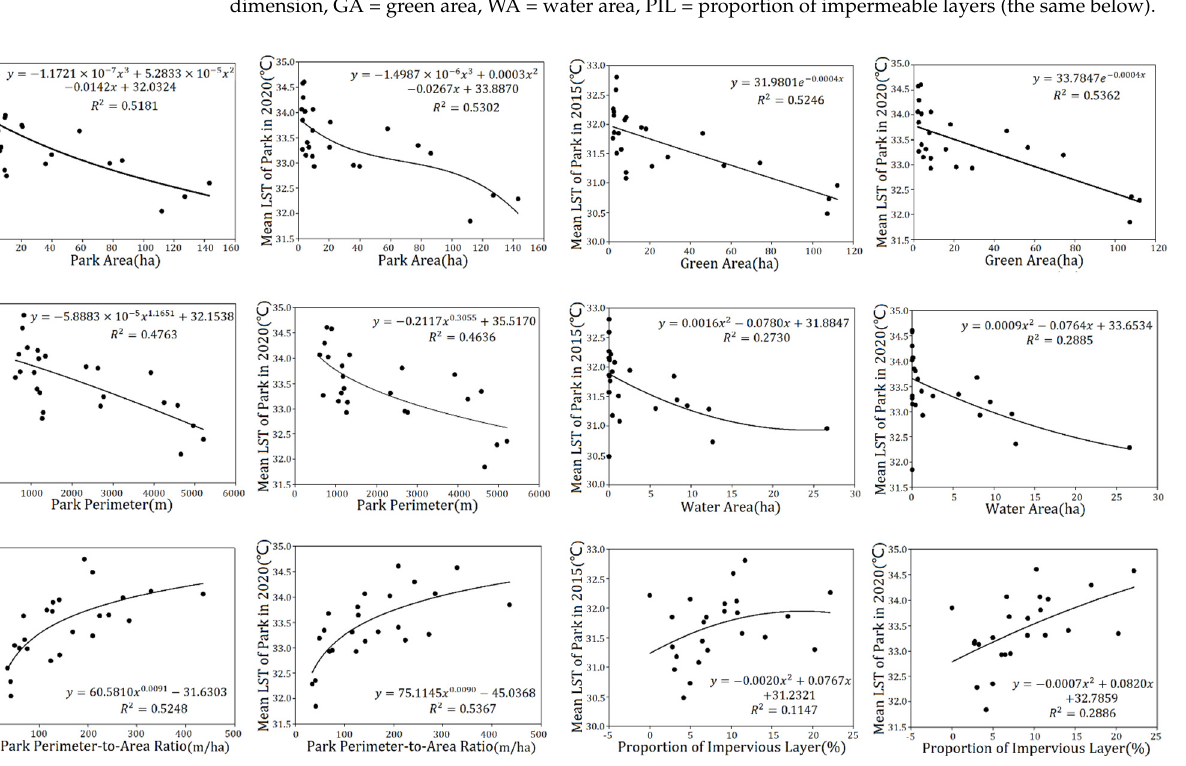
Figure 5. Regression analysis of park landscape metrics with mean LSTs in the parks. Note: LST = land surface temperature (the same below).